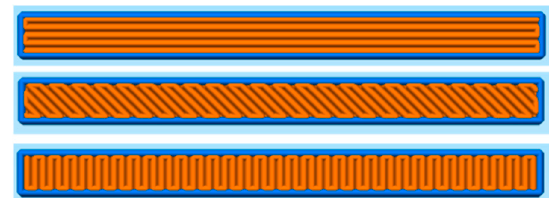
Figure 1. Fill pattern of perimeters (blue) and infills (orange) of one layer for specimens of each of the infill orientations, from top to bottom: 0°, ±45° and 90°.